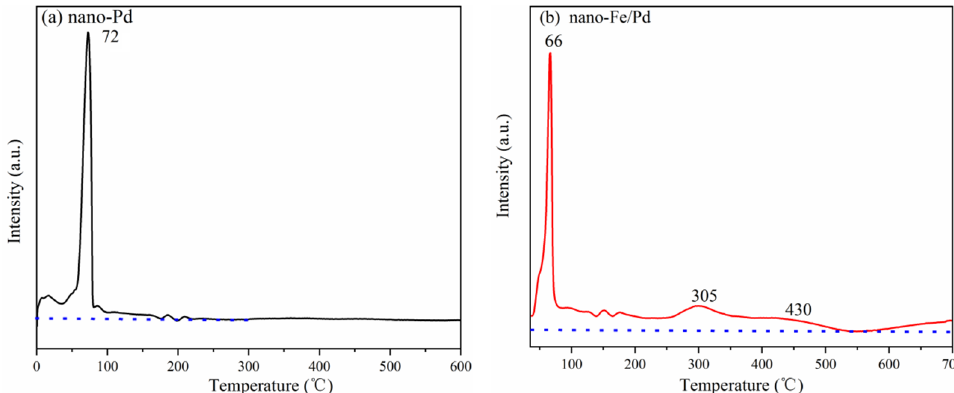
Figure 5. H 2 -TPR spectrum of nano-Fe/Pd ( a ) and nano-Pd ( b ) catalyst.